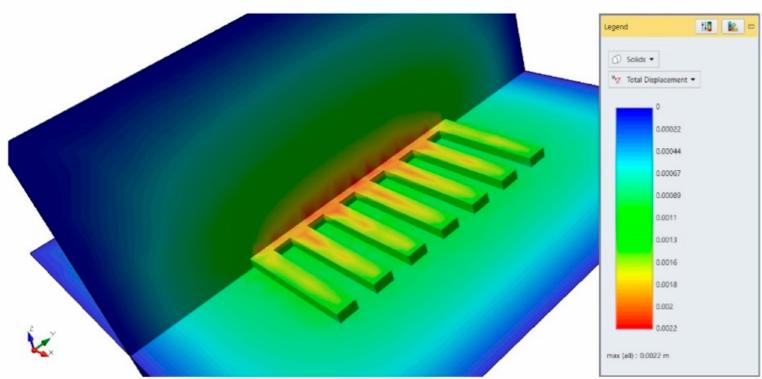
Figure 11. Total displacement for the mining field without cemented paste backfill.